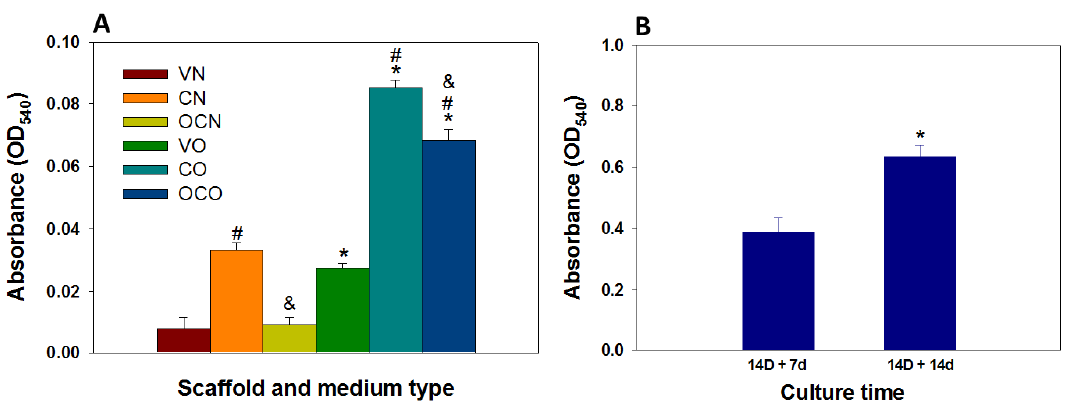
Figure 8. ( A ) Quantitative estimation of calcium deposition in V, C, and OC scaffolds after mono-culture of BMSCs in different scaffolds in normal medium (NM) and osteogenic medium (OM) for 14 days. VN, CN, and OCN denote V, C, and OC scaffolds in NM whereas VO, CO, and OCO denote V, C, and OC scaffolds in OM. * p < 0.05 compared with NM for each scaffold, # p < 0.05 compared with V for each medium, & p < 0.05 compared with C for each medium; ( B ) Total calcium deposition in the bone part of co-cultured BMSCs and chondrocytes in OC scaffolds. 14 D + 7 d denotes 14 days in osteogenic medium and 7 days in chondrocyte medium; 14 D + 14 d denotes 14 days in osteogenic medium and 14 days in chondrocyte medium. * p <